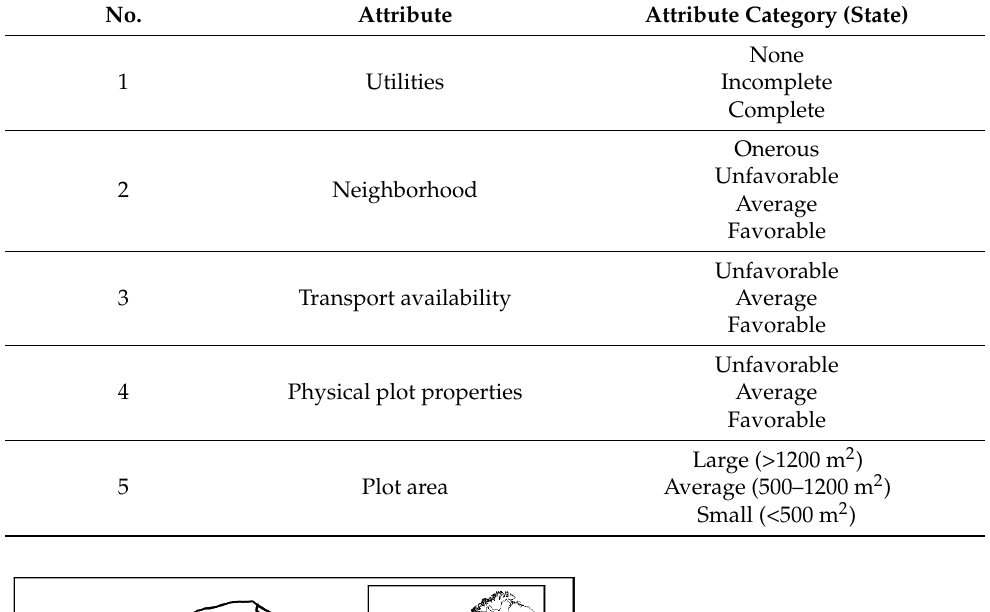
Table 1. Real estate attributes and their states.